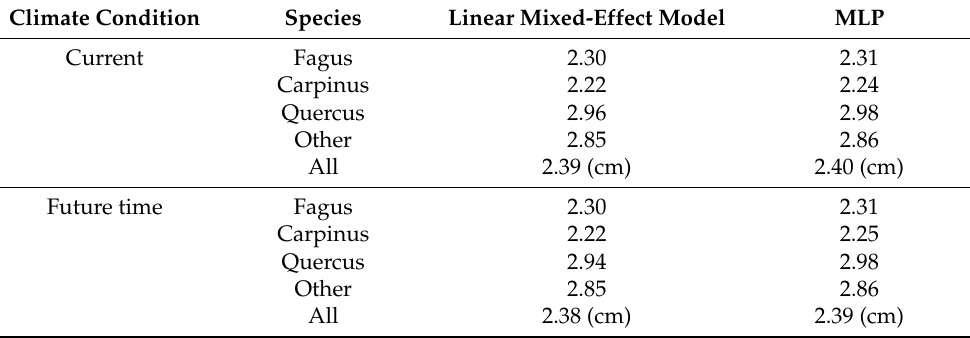
Table 11. Changes in individual diameter increment (cm) by regression and artificial neuron network under climate